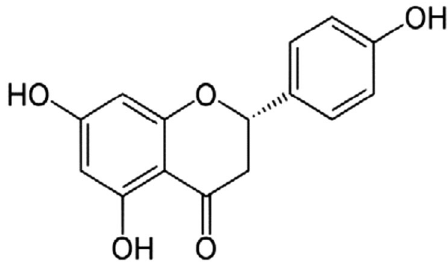
Fig. 9 Structure of naringenin (4 ′ ,5,7-trihydroxytlavanone) Fig. 10 Structure of gallic acid (3,4,5-trihydroxybenzoic